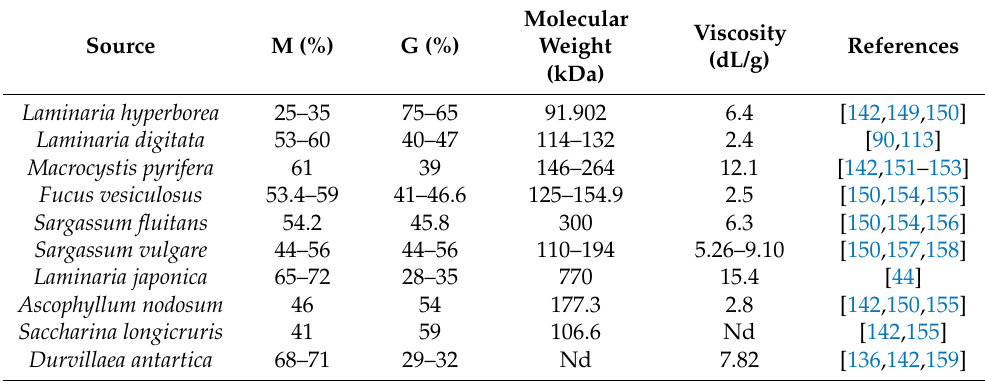
Table 2. The main alginate types from brown algae depend on the source, M/G ratio, molecular weight, and viscosity. Nd: not determined.